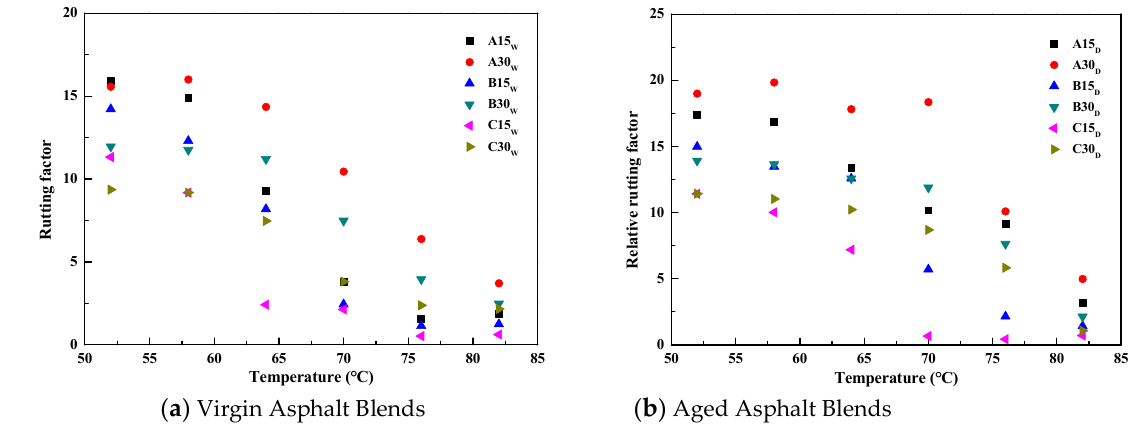
Figure 6. Variations of Δ G*/sinδ for reclaimed asphalt versus temperature.